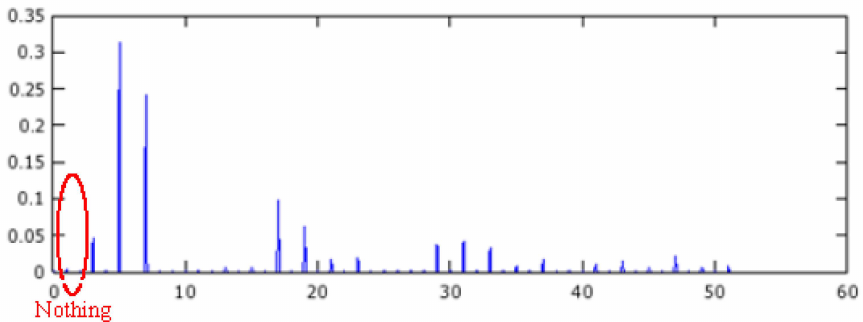
Figure 18. The amplitudes of harmonics of the MMF in the air-gap. The 12-slot structure is fed by two three-phase supplies shift electrically by 30 ˝ . The first harmonic has